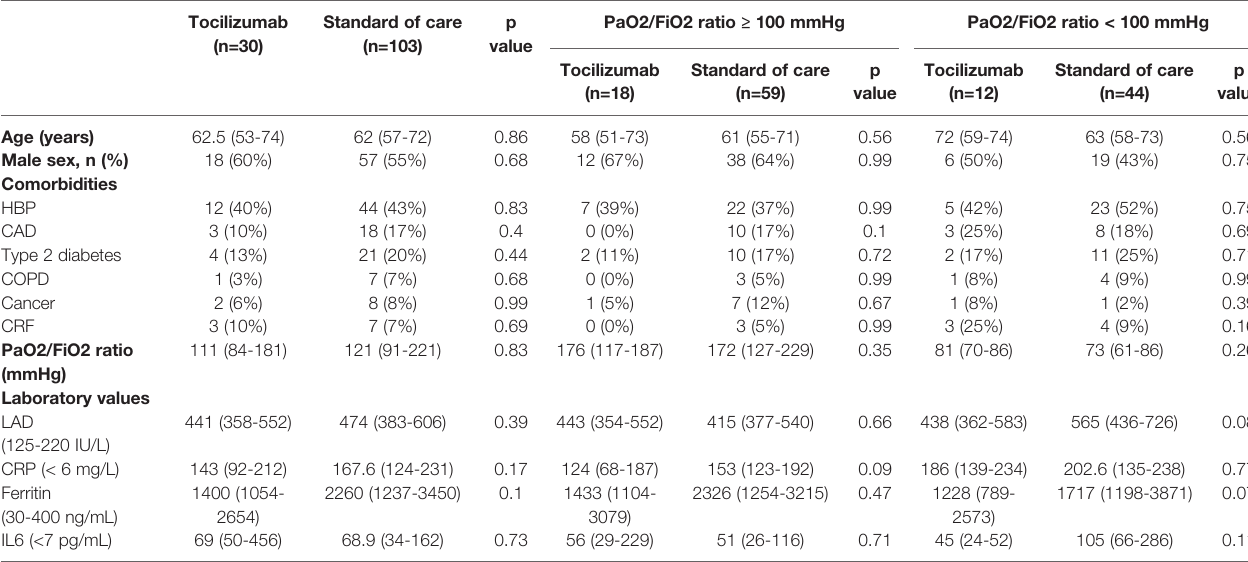
TABLE 4 | Clinical and serological features of patients treated with